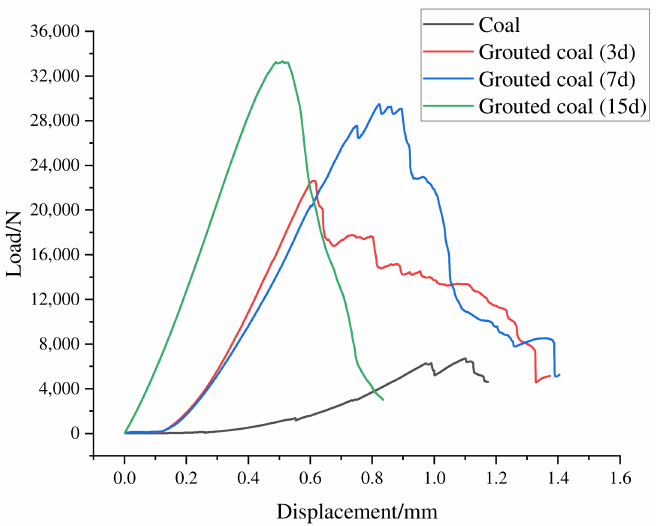
Figure 2. Load–displacement curve of coal and grouted coal in the failure processes.